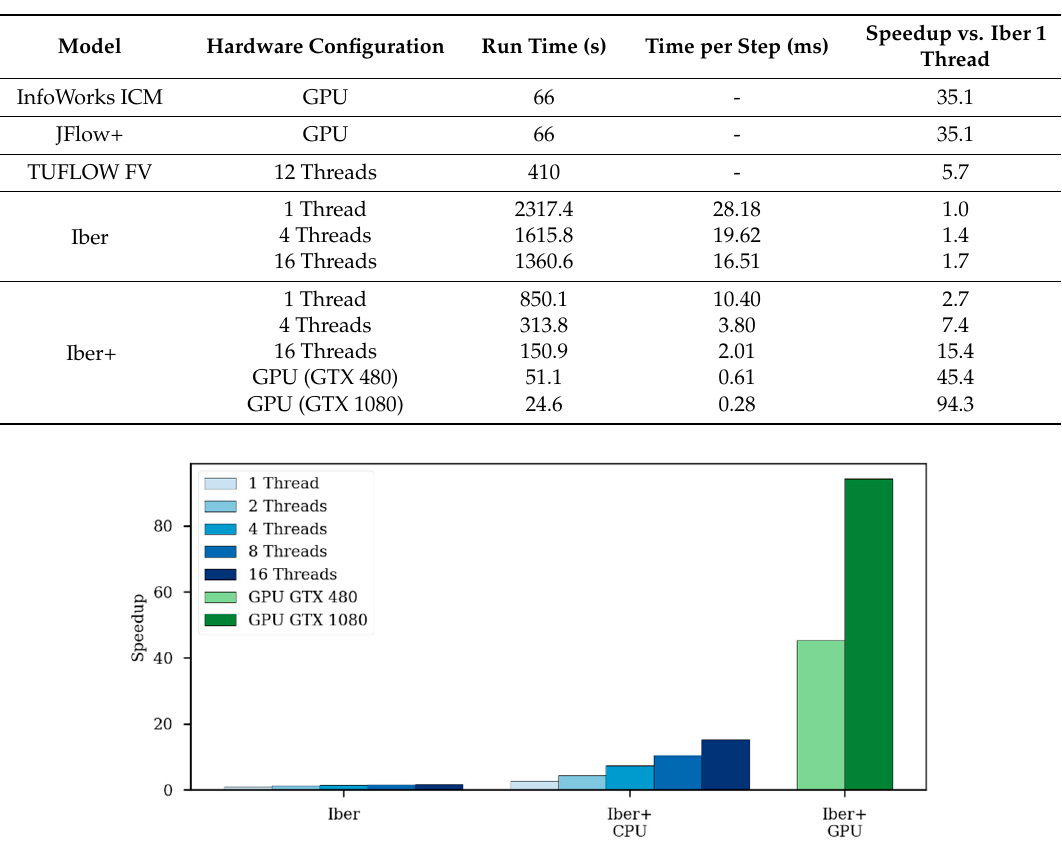
Figure 17. Speedups obtained comparing Iber running in one thread with different configurations in Test 8A.